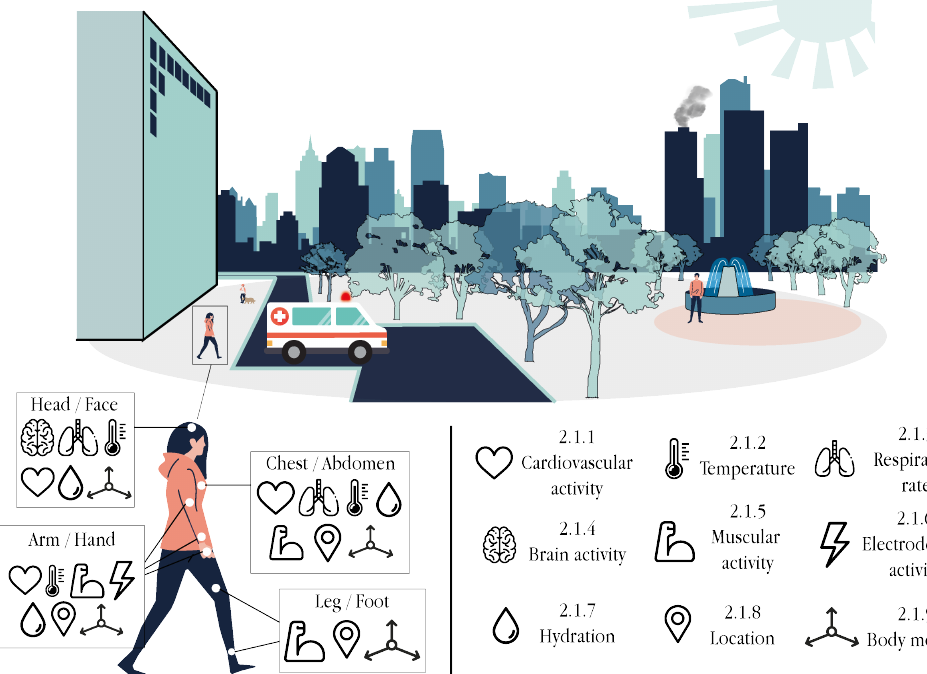
Figure 1. User-centric attributes for smart healthcare: each icon, representing the sensors of an attribute, is assigned to a part of the body where that attribute can be